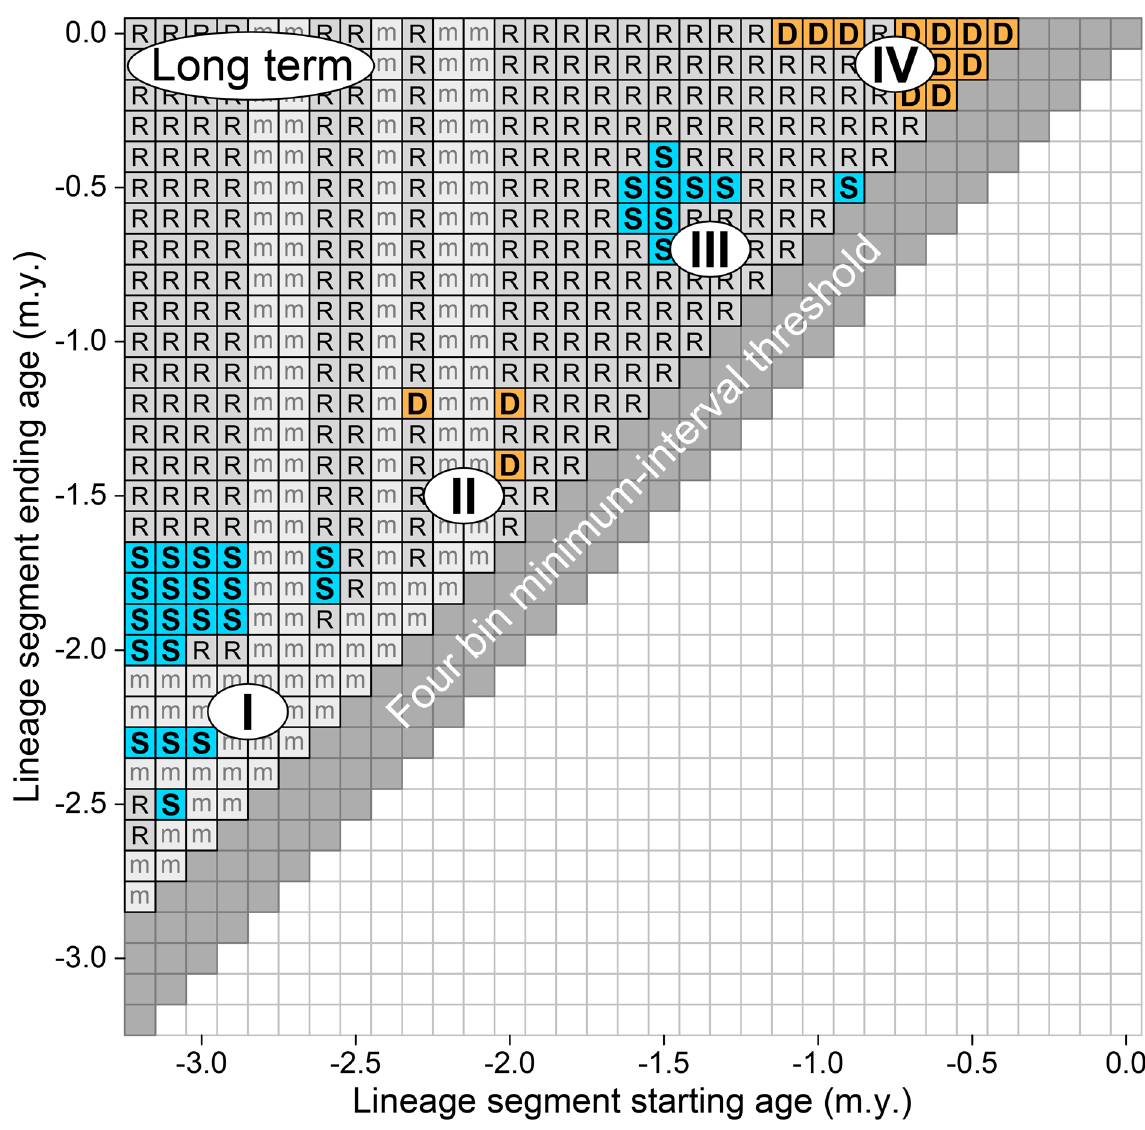
Figure 4. Statistical evaluation of brain size evolution in the broad lineage of Plio-Pleistocene hominins leading to modern humans (Fig. 3). The starting age for each lineage segment is shown on the abscissa and the ending age is shown on the ordinate. Empty bin segments are marked ‘m’ for missing. Each segment was analyzed following the protocol illustrated in Fig. 1c (minimum segment length required for statistical significance is five 100-k.y. bins). Time series segments with LRI temporal scaling slopes that cannot be distinguished from − 0.500 expected for random change are shown in gray and labeled ‘R’. Segments that can be distinguished from random change and directional change, representing relative stasis, are shown in blue and labeled ‘S’. Segments that can be distinguished from stasis and random change, representing directional change, are shown in yellow and labeled ‘D’. Note that the four phases identified in Fig. 3, phases I through IV, emerge as distinct modes in clusters of difference from random (again labeled I, II, The clusters of stasis (S) and directional change (D) for hominin brain size appear to be discrete on the map of Fig. 4, but there is some overlap in time between the clusters labeled I, II, III, and IV. The overlap is displayed in the bivariate graph of Fig. 5, which now includes the geological time scale of Fig. 3. Regression lines for ln ECV on age plotted in Fig. 5 are color coded to match the intervals of stasis and directional change in Fig. 4 that differ significantly from random. The successive phases in Fig. 5 labeled I, II, III, and IV are real in that they are based on stationary time series intervals statistically different from random and directional change, or based on directional time series intervals statistically different from stasis and random change. In addition, Fig. 5 shows that the phases overlap in time, meaning that the boundaries between the phases are diffuse. Inverse relationship of temporal scaling intercepts and slopes. Figure 6 is a graph of median tem- poral scaling intercepts plotted against their corresponding temporal scaling slopes, showing an inverse relation-